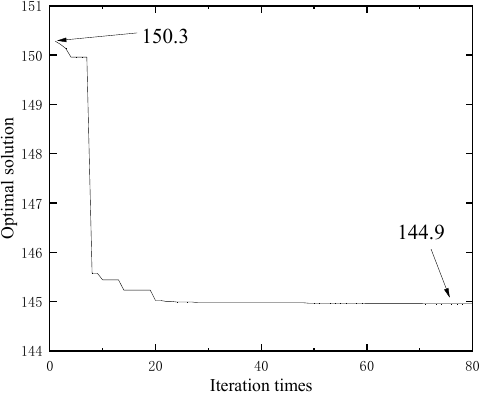
Figure 11. Iteration process of optimal solution (case M3). The critical failure model for the logarithmic spiral region obtained from the spatial discretization technique is presented in Figure 12 for the case M3, with the help of MATLAB software. The 3D velocity discontinuity surfaces all intersected with the potential slip surface.